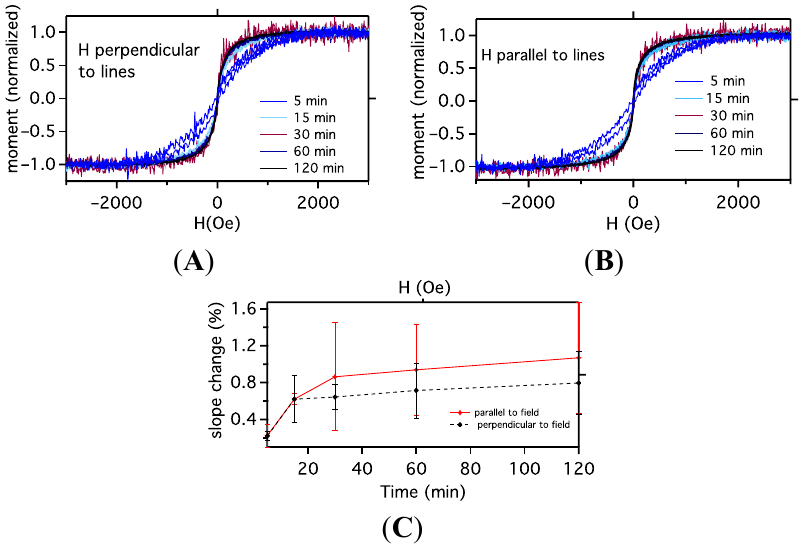
Figure 6. Magnetic moment as a function of external magnetic field for assembled nanoparticle patterns for different coating times measured: ( A ) with lines parallel to the applied field; and ( B ) with lines perpendicular to the magnetic field. Note the increase in slope as time increases. Since the slope change occurs for both orientations of magnetic field, it is likely not due to the increasing pattern width but due to clustering effects within the patterns, i.e. , not pattern–pattern interaction; Panel ( C ) shows the average slope of the m-H curve obtained at 20 and 100 Oe as a function of coating time, and while at long times, the perpendicular field loops have a lower slope than the parallel loops, the error bars overlap and thus beyond the slope change due to increasing feature size that is isotropic with direction, no difference between parallel and perpendicular fields can be claimed from the